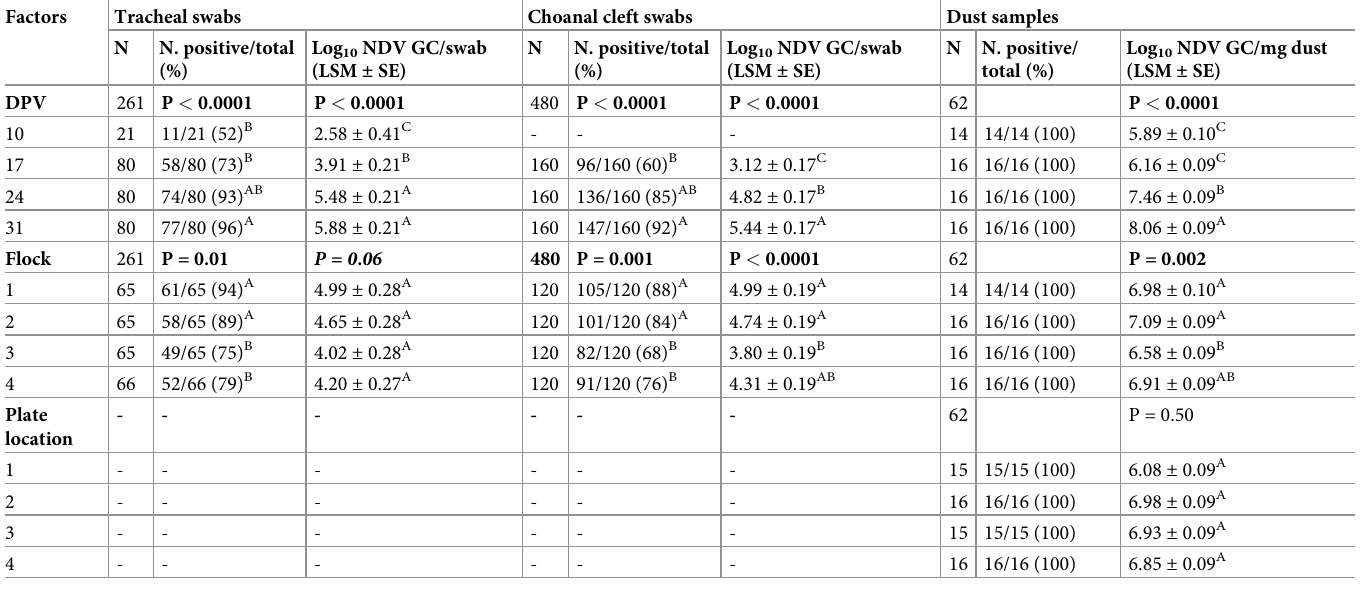
Bold text indicates statistically significant values (P < 0.05), bold text in italics indicate a trend for